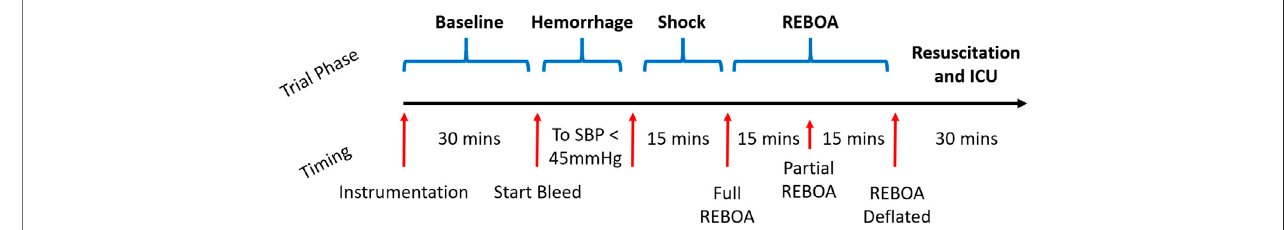
FIGURE 1 | Study Protocol Timeline. After the animals are instrumented and prepared, a 30-min window was observed for baseline data collection. They are then exsanguinated to systolic blood pressure (SBP) of 45 mmHg, and maintained in untreated hemorrhagic shock for 15 total minutes. The REBOA is then in fl ated and left in fl ated for 15 min, then partially de fl ated to 50% aortic occlusion. This is followed by REBOA de fl ation and then a 30-min ICU period where the animal is further resuscitated and additional labs are